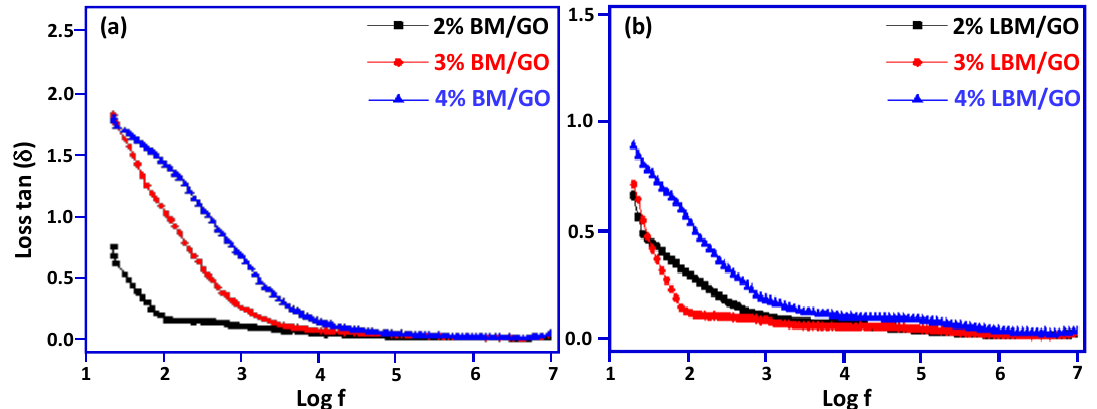
Figure 9. ( a ): Comparative graphs between tan δ and log f for composites X % BM/GO ( X = 2, 3, and 4) ( b ) X% LBM/GO ( X = 2, 3, and 4).